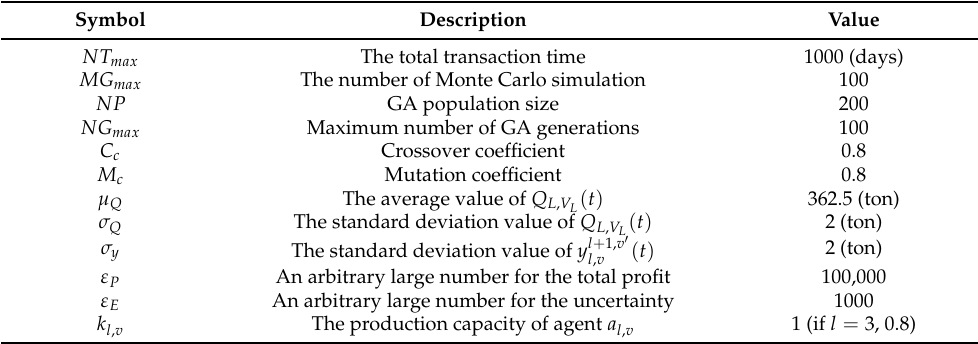
Table 2. The setting of the parameters for the Agent-based Modeling Multi-Objective Optimization (ABM-MOO).